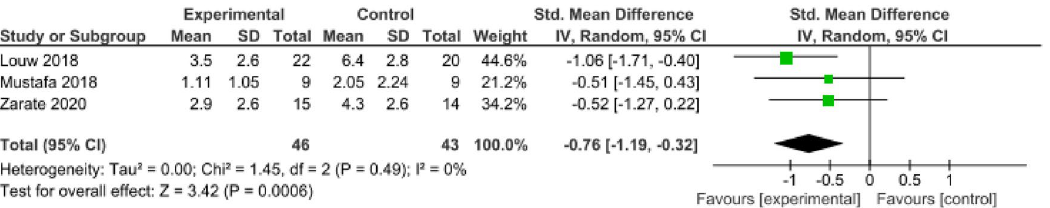
Figure 2. Dextrose versus Placebo injections for temporomandibular joint pain at 12 weeks.